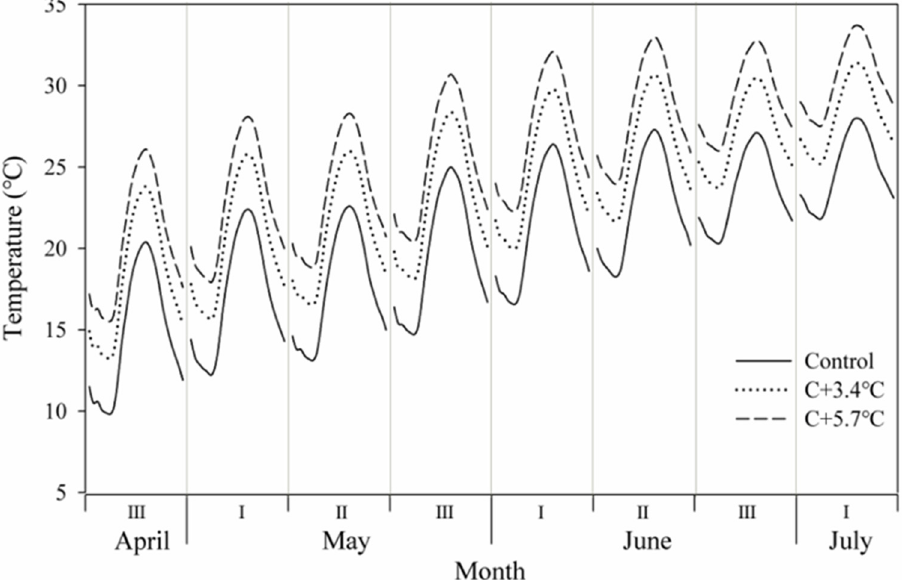
Figure 1. Application of diurnal temperature fluctuation during the experimental period. The solid line, dotted line and dashed line represent control, C+3.4 °C and C+5.7 °C respectively. I, the first 10 days of a month; II, the middle 10 days of a month; III, the last 10 or 11 days of a month.